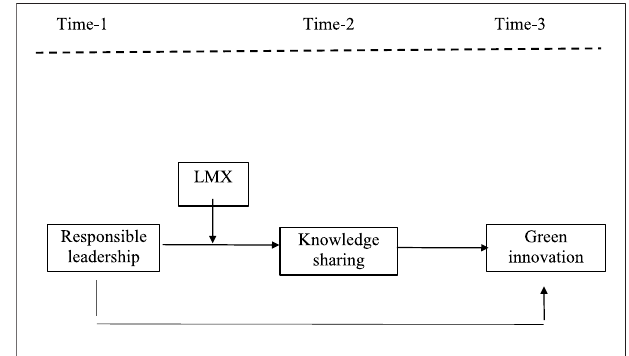
FIGURE 1 | Research